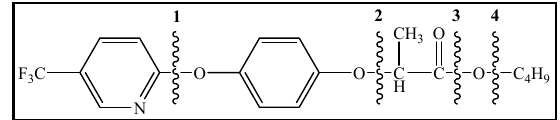
Figure 5. Possible cleavage sites for FPB molecules undergoing photocatalytic degradation.